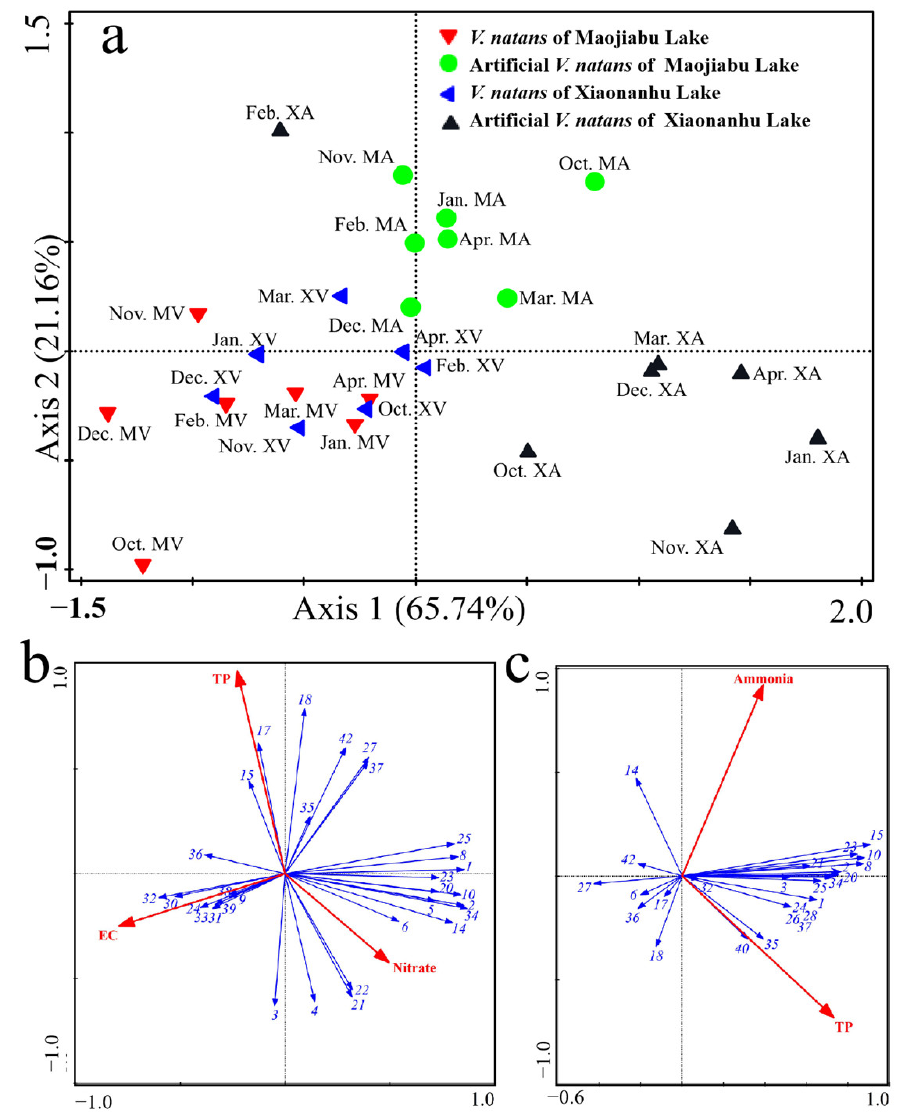
Figure 6. NMDS plot of periphytic-algae-dominant taxa in different substrates and sampling lakes ( a ). Redundancy analysis (RDA) ordination plots of physico-chemical parameters of water and periphytic algae cell density on V. natans ( b ) and artificial V. natans ( c ). 1 Cocconeis placentula , 2 Achnanthes minutissima , 3 Eunotia valida , 4 Eunotia pectinalis , 5 Fragilaria capucina , 6 Synedra acus , 7 Synedra amphicephala , 8 Navicula simplex , 9 Navicula exigua , 10 Navicula graciloides , 11 Navicula dicephala , 12 Gomphonema angustatum , 13 Gomphonema acuminatum , 14 Gomphonema constrictum , 15 Melosira granulata , 16 Diatoma vulgare , 17 Cyclotella meneghiniana , 18 Diploneis ovalis , 19 Cymbella affinis , 20 Ulothrix tenerrima , 21 Cladophora oligoclona , 22 Characium strictum , 23 Chlorella vulgaris , 24 Scenedesmus bijuga , 25 Stigeoclonium aestivale , 26 Spirogyra sp., 27 Chamydomonas ovalis , 28 Zygnema sp., 29 Dictyosphaerium pulchellum , 30 Cryptomons ovata , 31 Chroomonas acuta , 32 Dinobryon sertularia , 33 Mallomonas sp., 34 Lyngbya perelagans , 35 Oscillatoria tenuis , 36 Merismopedia punctata , 37 Pseudanabaena sp., 38 Anabeana sp., 39 Aphanizomenon sp., 40 Protoderma sp., 41 Rivularia sp., 42 Rhabdoderma lineare